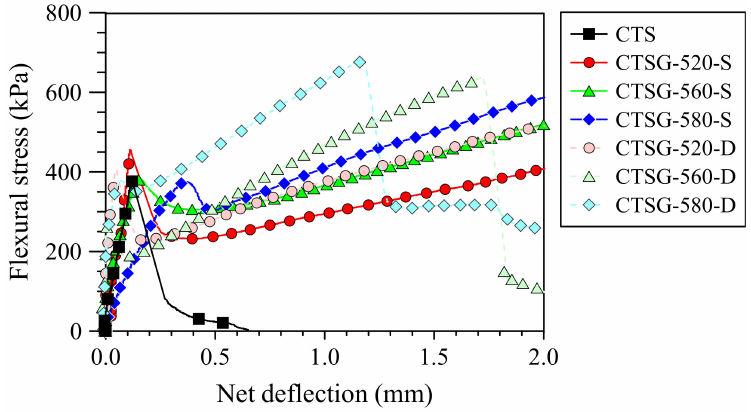
Figure 5. Flexural stress-net deflection